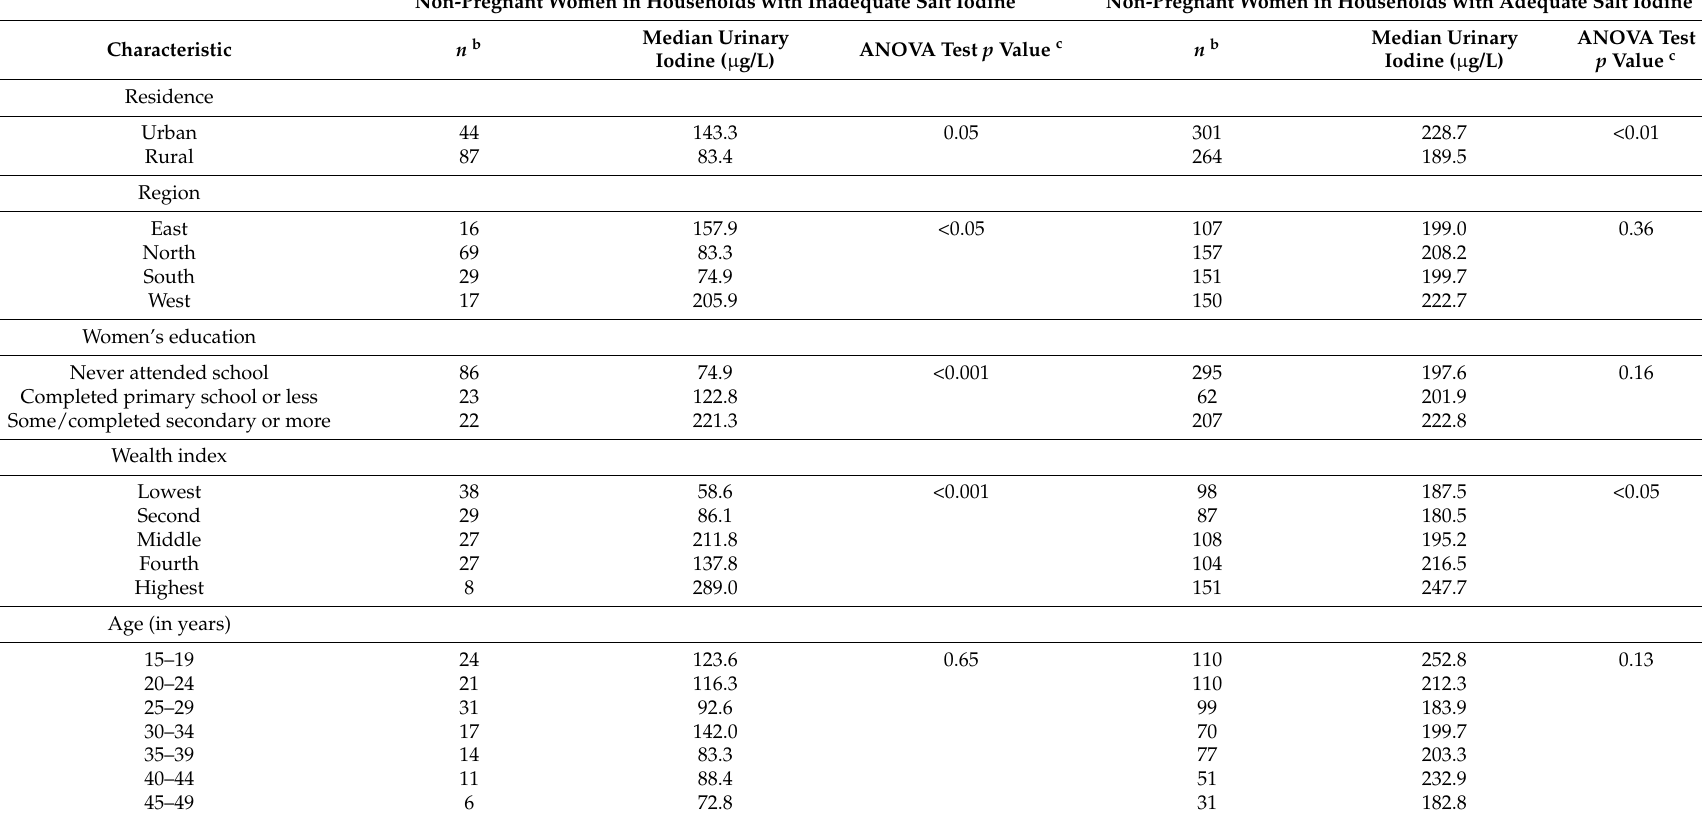
Table 5. Weighted median urinary iodine in non-pregnant women (15–49 years), by various demographic characteristics and adequacy a of salt iodization, Sierra Leone 2013. Non-Pregnant Women in Households with Inadequate Salt Iodine Non-Pregnant Women in Households with Adequate Salt